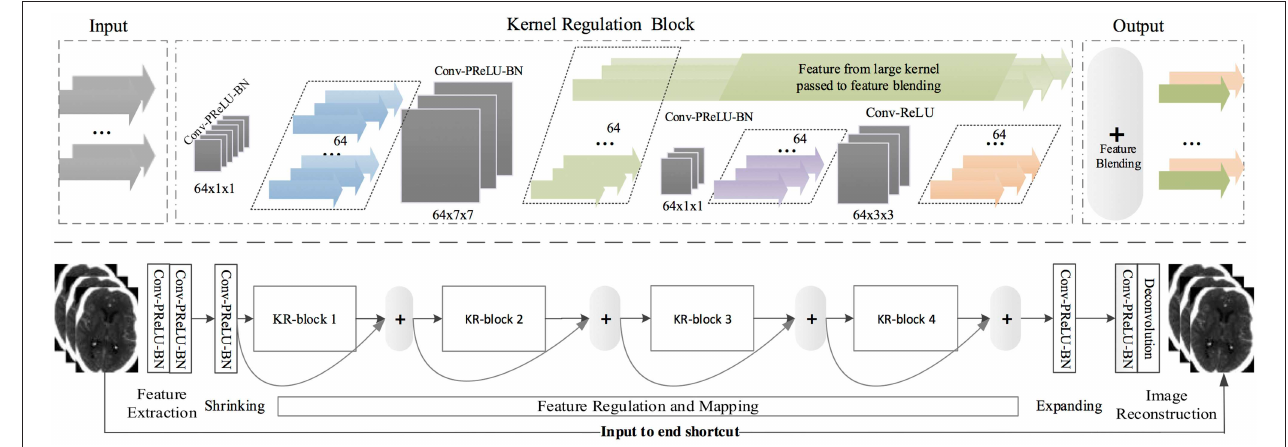
FIGURE 1 | (Top) A kernel regulation block (KR-block) with a massive of convolution computations (128 × 7 × 7) comprises two 1 × 1 convolution components for computation reduction and one 3 × 3 convolution module for regularizing the features extracted by the preceding large size kernels. The number of dark-gray blocks indicates the quantity of kernels in the current convolutional layers, and the size of dark-gray blocks represents the size of kernels and the density of convolution. The color arrows represent the quantity of feature-map outputs. (Bottom) SRDN is consisted of feature extraction, shrinking, regulation and mapping, expanding, and image reconstruction. Four KR-blocks are embedded in the proposed